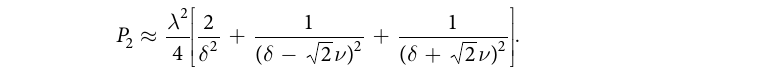
The P 2 is shown in Fig. 8 for two groups of parameters. The effective decoherence rates due to the atomic spon- 4 and κ κ ′ = < . × − P g 0 35 10 3 , taneous emission and the decay of the Bosonic modes are Γ′ = Γ < − P g 10 1 2 respectively. The fidelity of the iSWAP gate is defined by ∫ ρ ρ ρ =   F Tr (29) iSWAP o i o over all possible states, where ρ o denotes the real final density matrix while ρ i denotes the ideal final density matrix. The fidelity of the iSWAP gate is shown in Fig. 9. For the small ≈ . g 5 275 , the fidelity may be reached to 0.982 after the evolution time ≈ . t 19 575 , see Fig. 9(a). For the large ≈ . g 18 4 , the fidelity may be reached to 0.994 after the evolution time ≈ . t 6 375 . The ideal iSWAP gate is achieved after eight Rabi-like oscillations, see Fig. 10. In the regime ν  g the fidelities of the gates have been consistently found to be essentially unaffected by fiber i losses. In general, moreover, the direct effect of spontaneous emission proves to be more relevant than the indirect